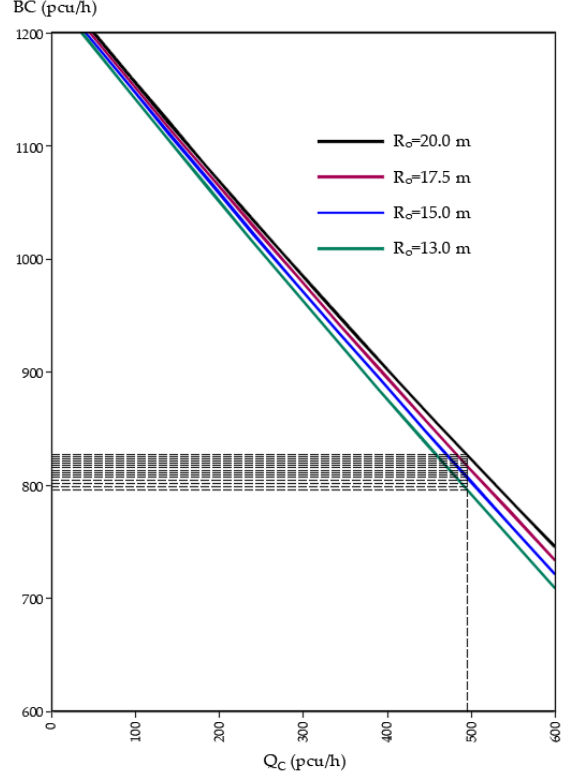
Figure 5. Base capacity at single-lane roundabouts as a function of outer radius.